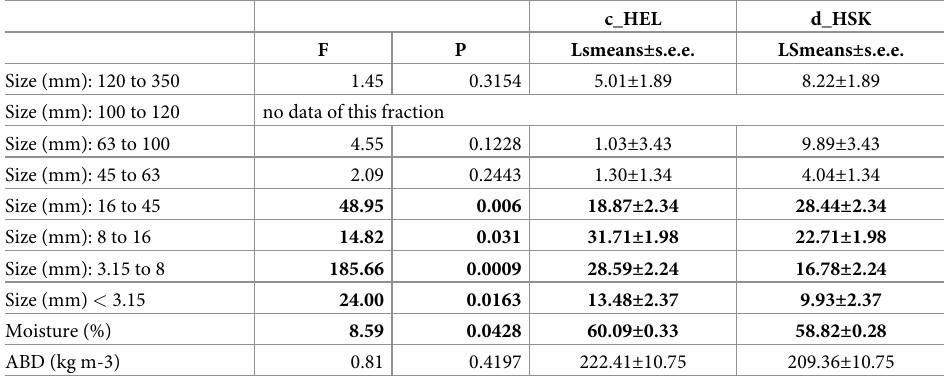
Table 6. Quality of the chipped material in peach at varying the knife type (d_HSK, hoe shaped knives, c_HEL, Helicoidal knives). Quality traits were the size distribution of the material, the mean moisture and the apparent bulk density (ABD). Fractions varying at p > 0.05 are shown in